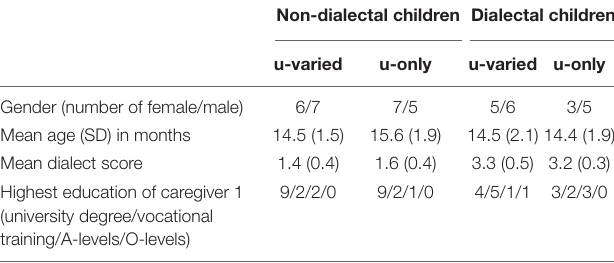
TABLE 3 | Overview of participant metadata. TABLE 4 | List of words and their IPA-transcription (first two columns) and the generated nonce-words (last two